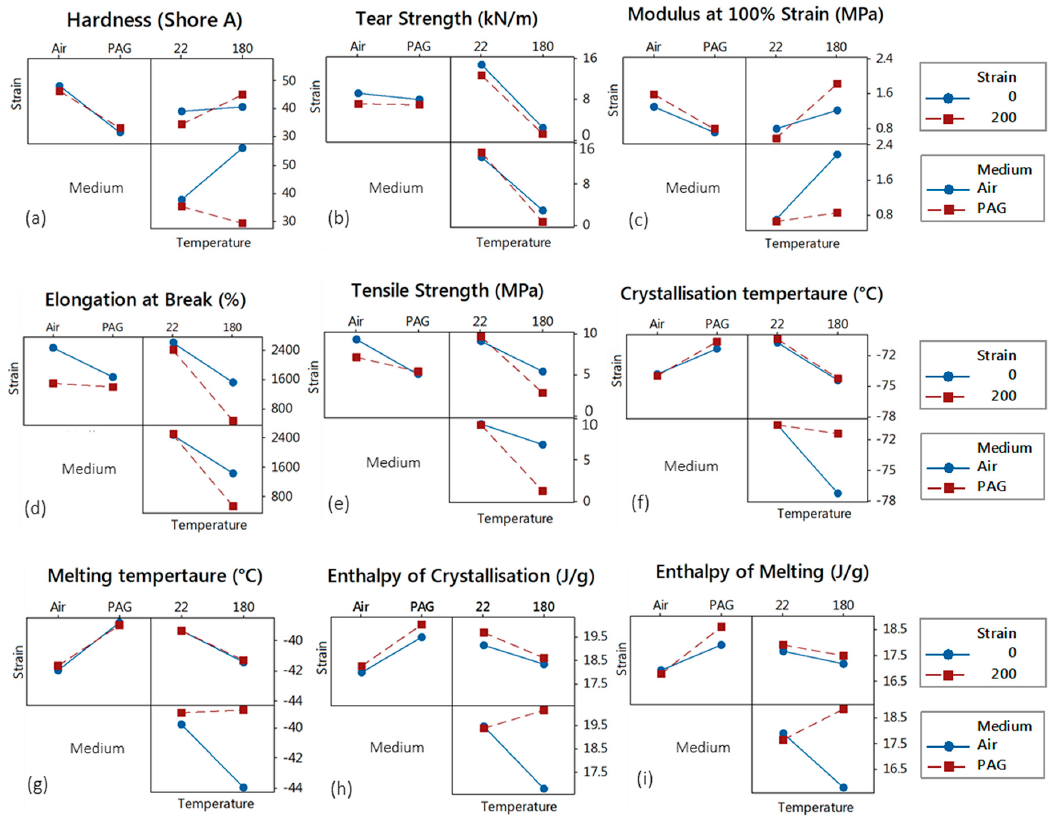
Figure 11. Interaction effects of ageing factors on the mechanical and thermal properties of the SR samples.